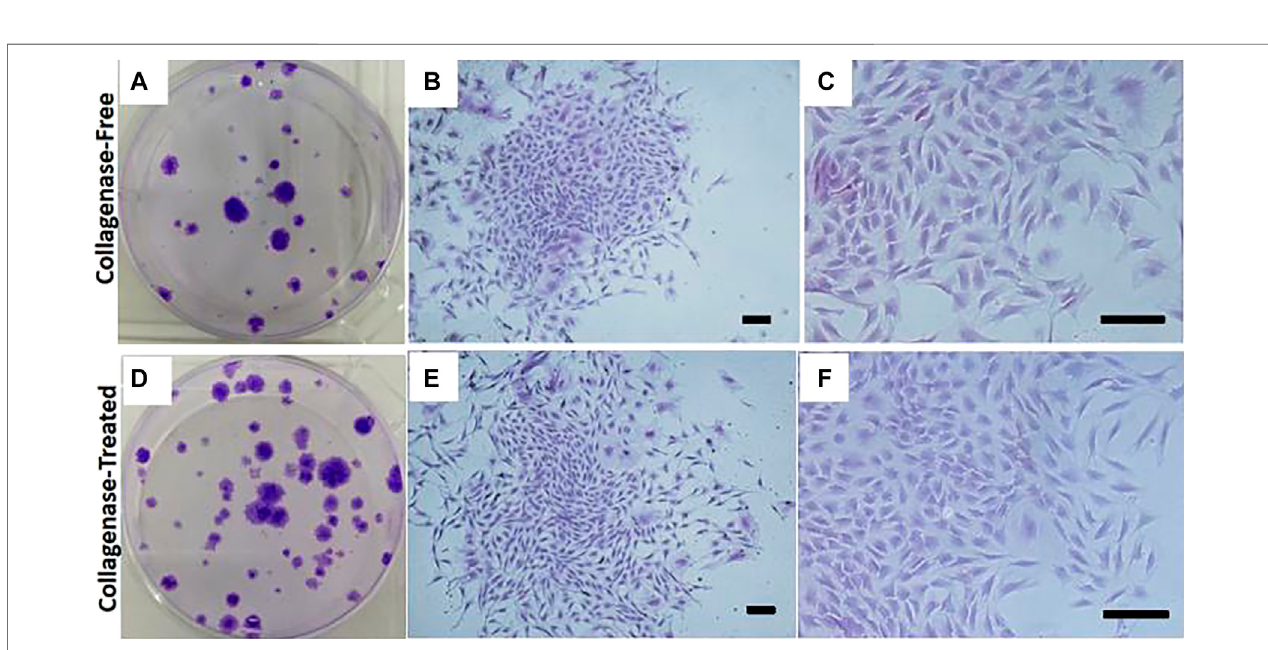
FIGURE 2 | Representative colony assay of primary cell culture isolated and extracted by the without enzyme method and enzyme digestion method. Scale bar = 200 μ m.